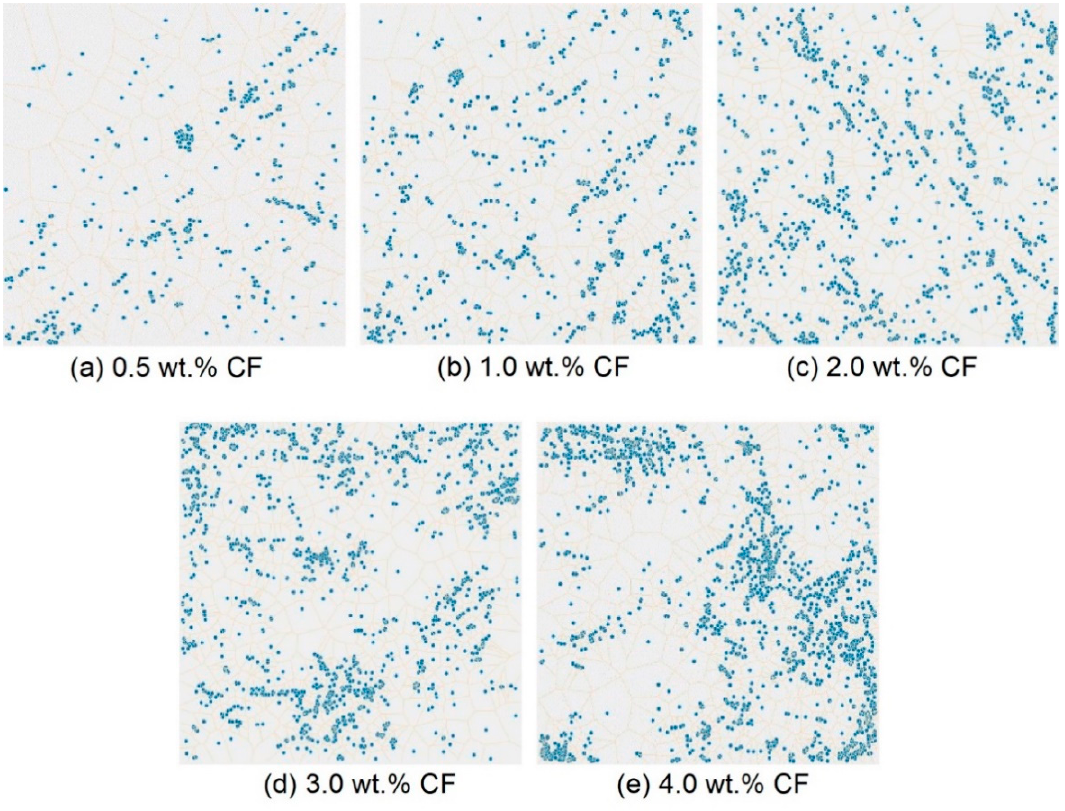
Figure 10. Voronoi diagram of the carbon fiber distribution under different carbon fiber contents: ( a ) 0.5 wt.%; ( b ) 1.0 wt.%; ( c ) 2.0 wt.%; ( d ) 3.0 wt.%; ( e ) 4.0 wt.%.